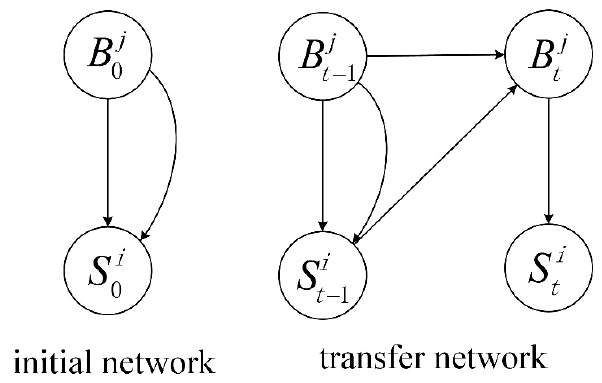
Figure 9. Initial network and transfer network of dynamic Bayesian network.